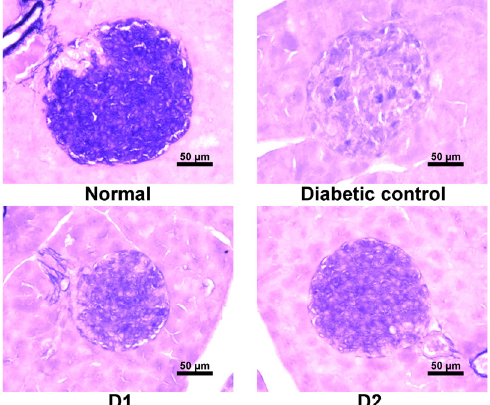
Figure 6. Photomicrograph of pancreatic islet of normal, diabetic, and OFS treated mice stained with aldehyde fuchsin. Normal db/ ‐ mice control (NC); db/db mice control (DC); db/db mice fed 1 g/kg body weight of OFS (D1); db/db mice fed 2 g/kg body weight of OFS (D2). β‐ cells in pancreatic islets stained purple ‐ violet. Bar = 50 μ m.